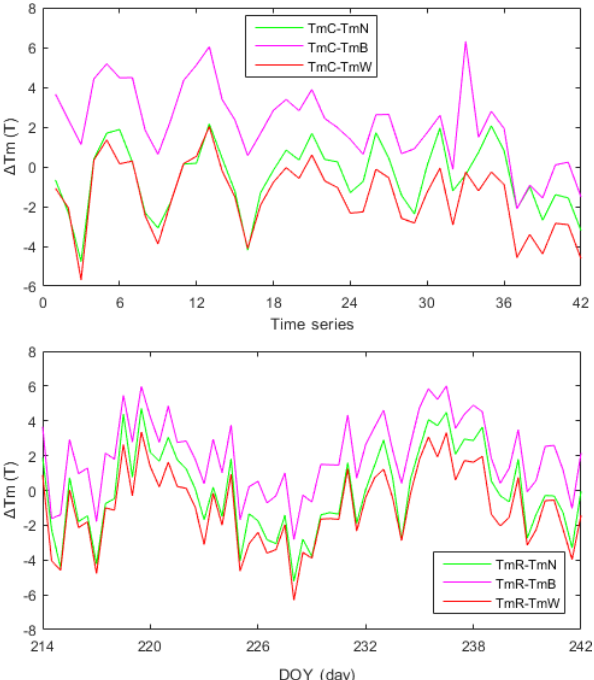
Figure 3. New T m model values are compared with those derived from COSMIC and radiosonde products in Hong Kong in Au- gust 2016. TmC is the T m derived from COSMIC products, TmN is the T m derived from the new model, TmB is the T m derived from the Bevis model, TmW is the T m derived from the Wang model, and TmR is the T m derived from radiosonde products.